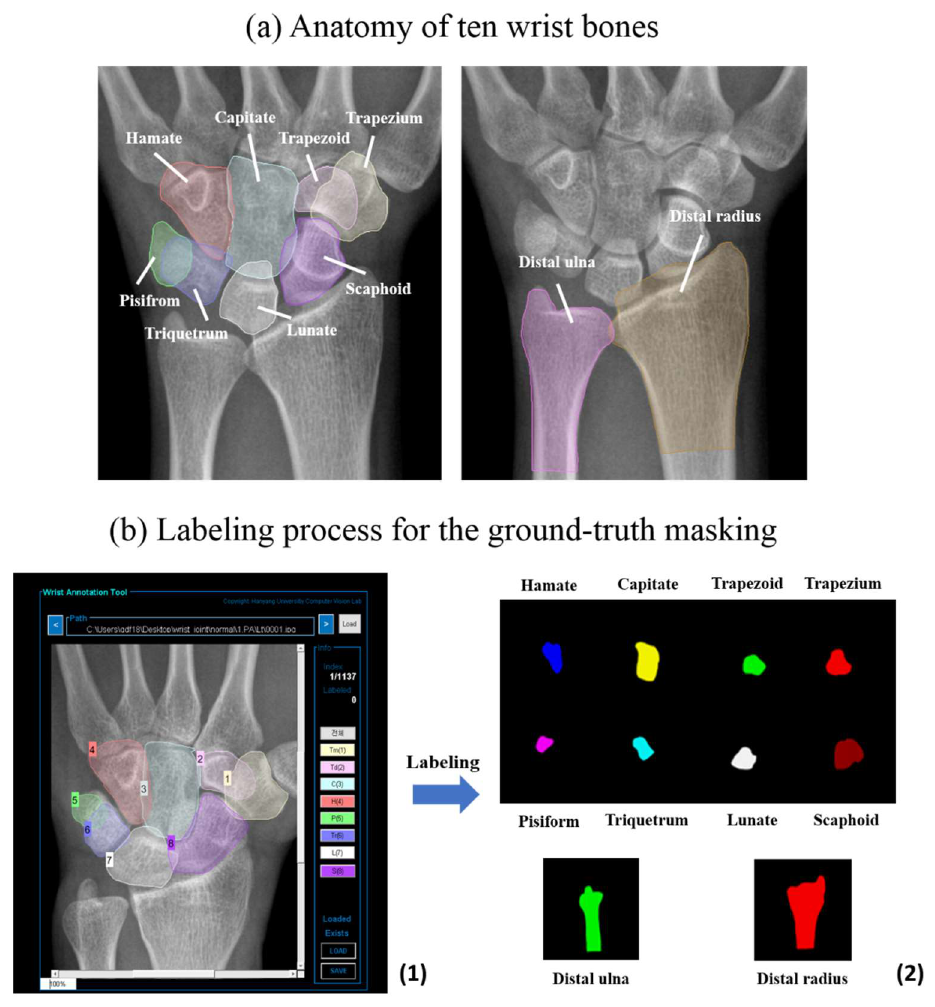
Figure 1. Anatomy and labeling of ten wrist bones on a wrist radiograph. ( a ) The anatomy of ten wrist bones, consisting of eight carpal bones and two distal forearm bones, on an anteroposterior radiograph. ( b ) Labeling process for the ground truth masking of wrist bones using a self-made customized tool. ( 1 ) The classification as one of ten wrist bones and the delineation of each bone’s boundary; ( 2 ) Labeling and extraction of each bone.